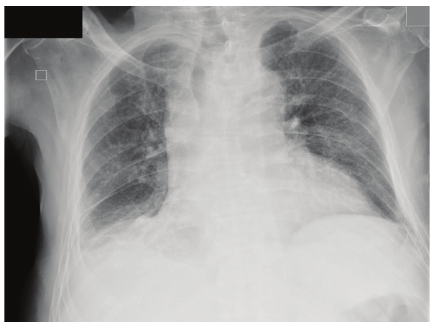
Figure 6: Control chest X-ray on the follow-up visit. Radiological improvement of the right lower lobe alveolar infiltrate.